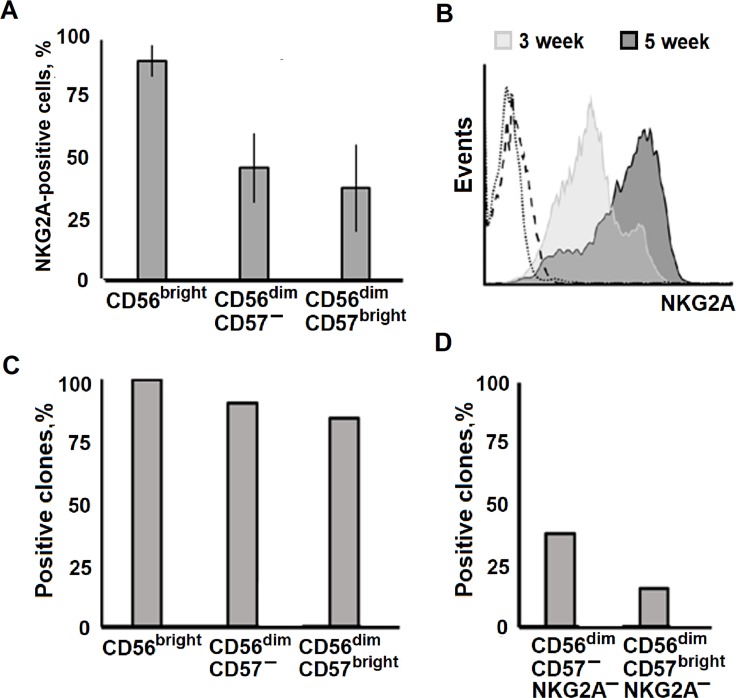
Surface expression of NKG2A in NK cell clones.(A) Proportions of CD56bright, CD56dimCD57–, and CD56dimCD57bright subsets in NK cells ex vivo. Mean ± SD of 8 independent experiments is presented. (B) Dynamics of NKG2A surface expression in a NK cell clone from CD56brightHLA-DR+ subset. The dotted line indicates autofluorescence, dashed line–isotype. (C) Analysis of NKG2A expression in clones obtained from different subsets, analyzed after 5 weeks of cultivation. In each subset, the proportion of NKG2A-positive clones is presented (mean ± SE of n clones obtained in 4 clone collections: n = 30 for CD56bright, n = 31 for CD56dimCD57–, n = 19 for CD56dimCD57bright subsets). (D) Analysis of NKG2A expression in clones obtained from CD56dimCD57–/brightNKG2A– subsets, carried out after 5 weeks of cultivation. The proportions of NKG2A-positive clones are presented (mean ± SE of n independent experiments: n = 21 for CD56dimCD57–NKG2A–, n = 19 for CD56dimCD57brighNKG2A– subsets).